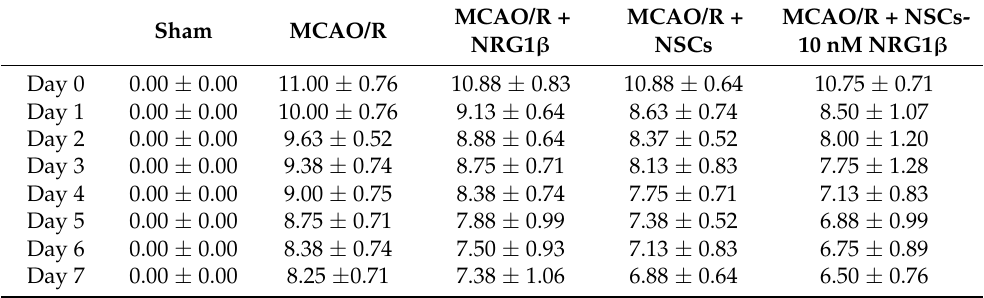
Table 3. mNSS score (Mean ±